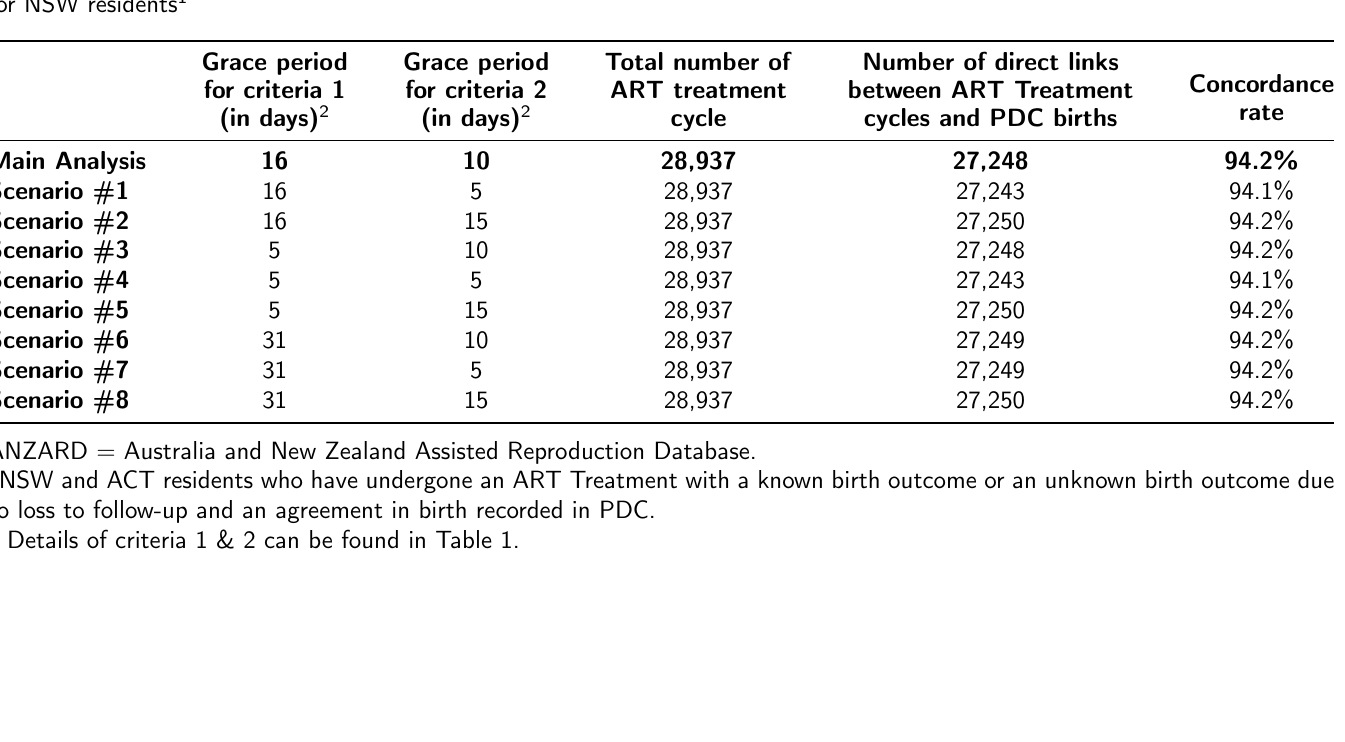
Supplementary table 3: Concordance of plurality status between ANZARD and PDC data 1 , for New South Wales (NSW) residents